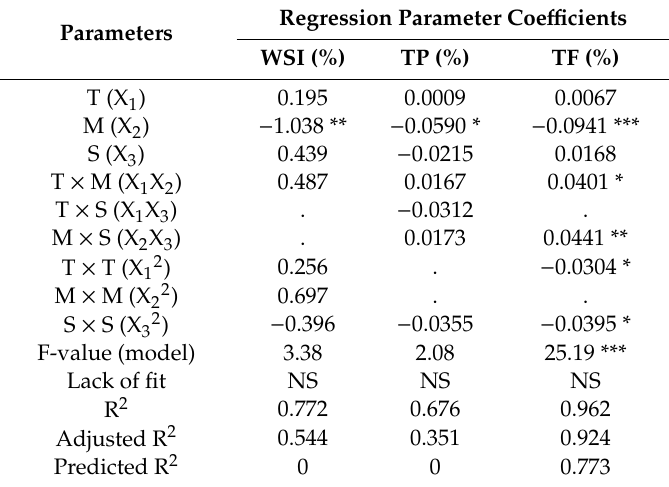
Table 2. Regression summaries for independent